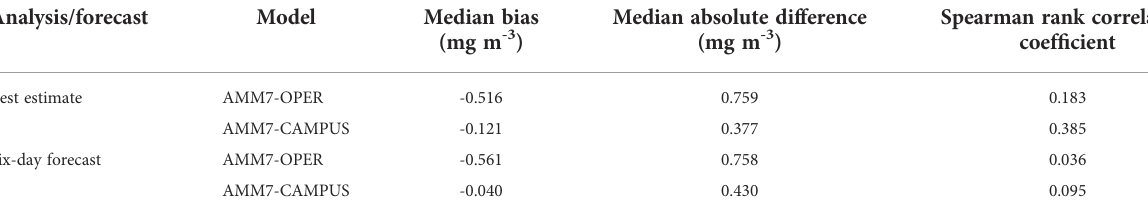
TABLE 1 Validation statistics for AMM7-OPER and AMM7-CAMPUS chl- a against E1 data. Analysis/forecast